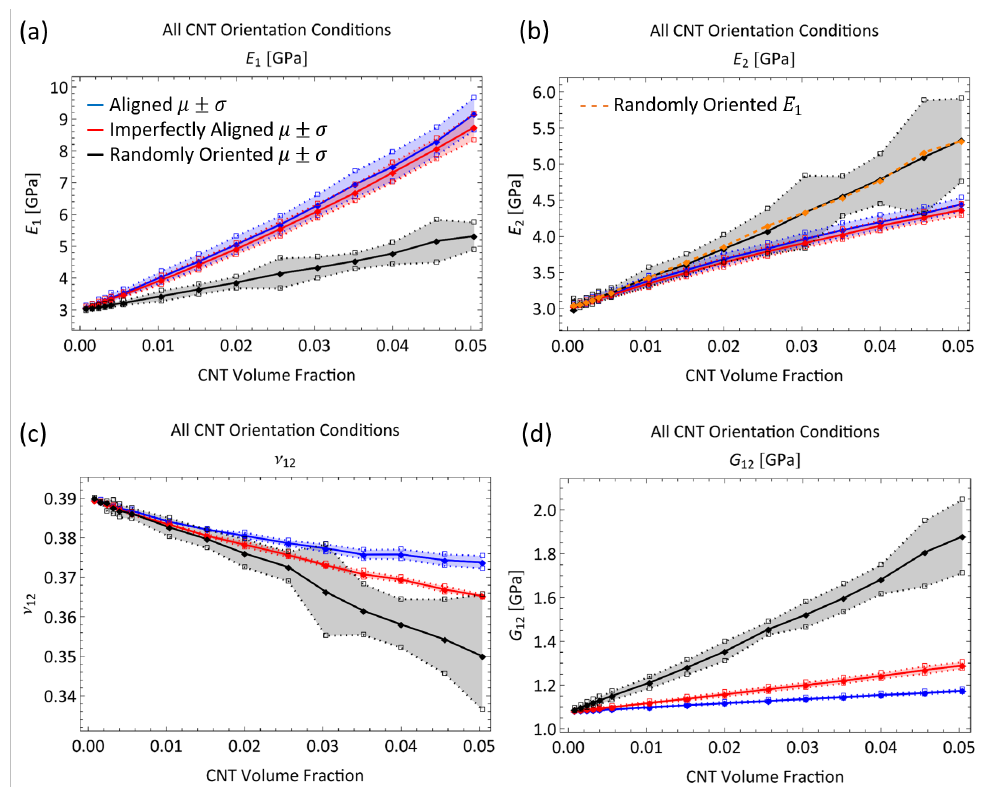
Figure 11. Estimate of engineering constants ( a ) E 1 , ( b ) E 2 , ( c ) ν 12 and ( d ) G 12 for all three orientation conditions with straight